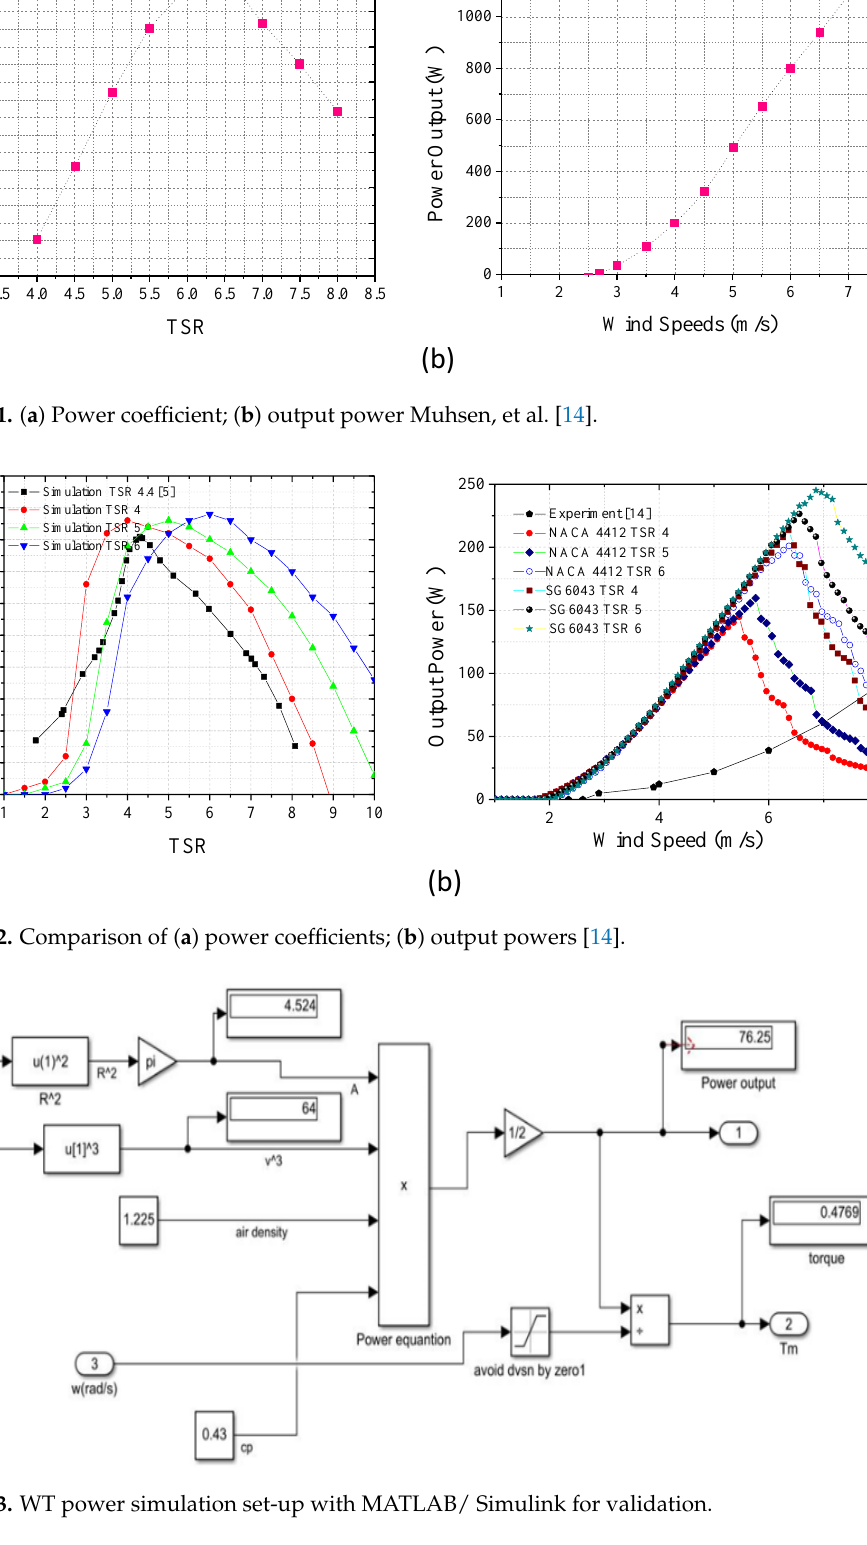
Figure 24. Compared power output at design wind speeds obtained with Q-blade and MATLAB/ Simulink for ( a ) NACA 4412 rotor blade ( b ) SG6043 rotor blade. 4. Conclusions In this work, the design of small horizontal axis wind turbine blades was performed using blade element momentum theory. A total of three blades were considered, and the blade pitch angle was kept constant at 0° angle throughout the power simulations. Calcu- lations of the parameters for the design were achieved by employing MATLAB software, while the remaining tasks, such as airfoils analysis, rotor blade design, and power simu- lation, were performed using Q-blade software. Overall, four digit airfoils of NACA 4412 and SG6043 were considered, and analysis was performed at varying Re of 1.0 × 10 5 , 1.5 × 10 5 , 2.0 × 10 5 , 2.5 × 10 5 , and 3.0 × 10 5 .The highest power coefficients were obtained at the Re of 3.0 × 10 5 for all the TSR values (4,5, and 6). However, the highest value of power coefficient and power output was obtained at TSR 6. Power coef- ficients values of 0.42, 0.43, and 0.44 were achieved with NACA 4412 rotor blades, while power coefficient values of 0.43, 0.44, and 0.45 were realized with SG6043 rotor blades at the TSR 4, 5, and 6. Moreover, at the TSR 4, 5, and 6, the blades were able to harvest powers of up to 144.73 watts (W), 159.69 W, and 201.04 W with the NACA 4412, and 213.15 W, 226.44 W, and 245.09 W with the SG6043 blades. Moreover, the main admirable achieve- ment of this work is that the design blades were able to harvest wind powers of 79.3 W and 80.10 W at the design wind speed of 4 m/s with the NACA 4412 and SG6043 rotor blades, respectively. In addition, at TSR 4, both the NACA 4412 and SG6043 rotor blades exhibited the lowest cut-in speed of 1.80 m/s and 1.70 m/s, respectively. These represent the best result ever obtained with a 1-m radius length rotor blade at the low wind speed of 4 m/s. ( a )